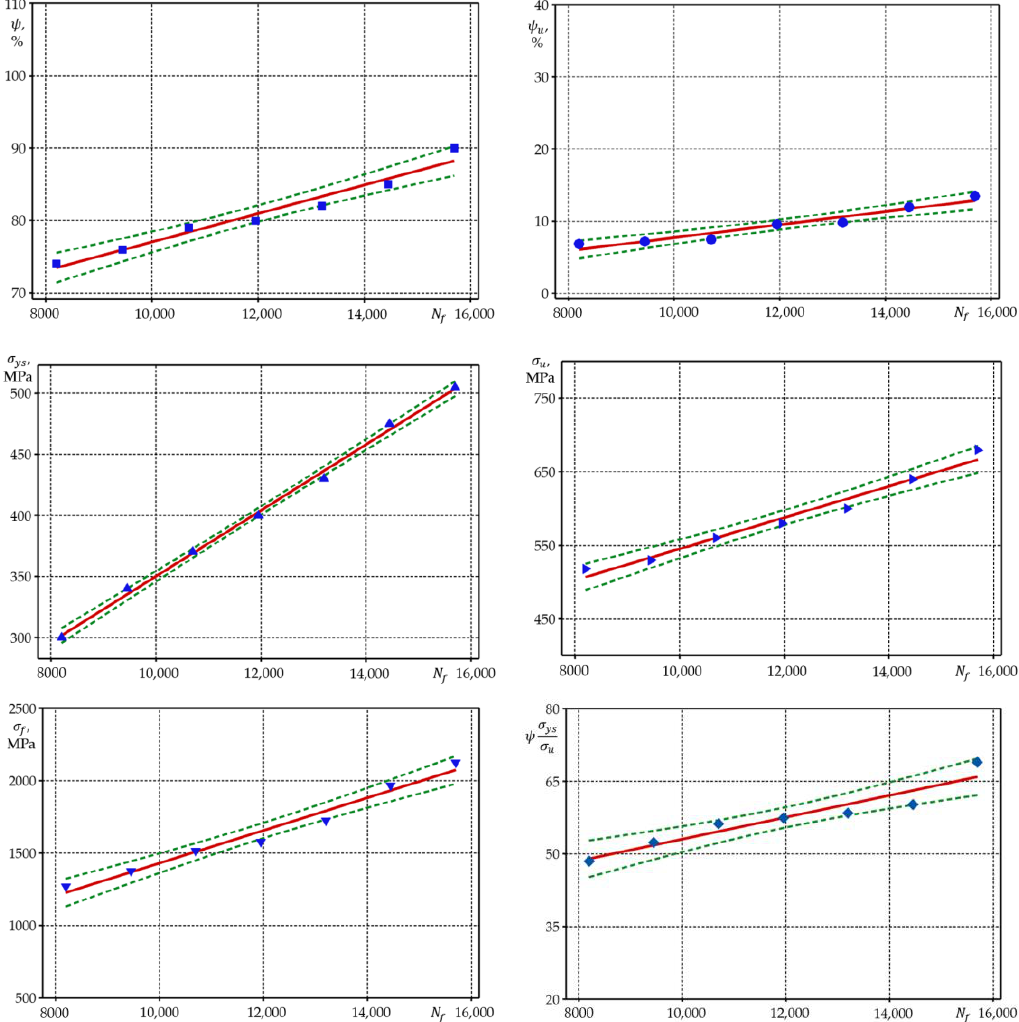
Figure 5. Regression lines under strain-controlled loading for steel 15Cr2MoVA ( 𝑒̅ 0 = 1.8) . Dots represent the experimental values, straight lines ‒ the theoretical calculated dependencies, while dashed lines represent confidence intervals.